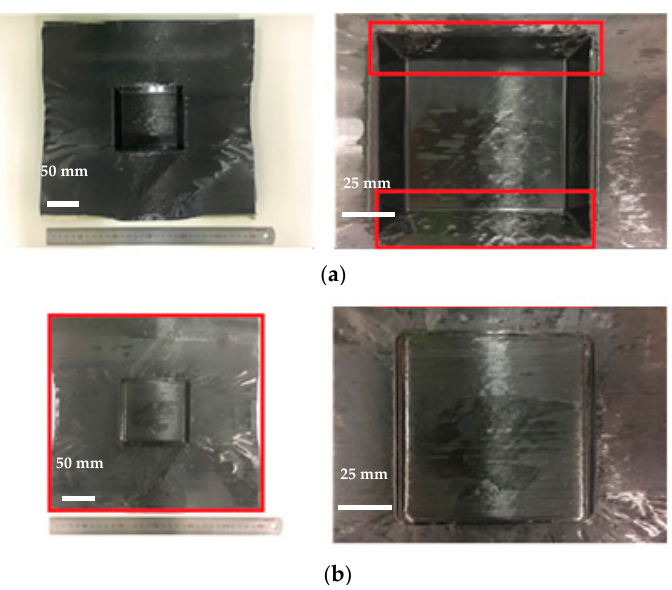
Figure 8. ( a ) Inner layer and ( b ) outer layer of the thermoformed square-cup for the Type 1 mold design with the pattern 2 prepreg laminate.